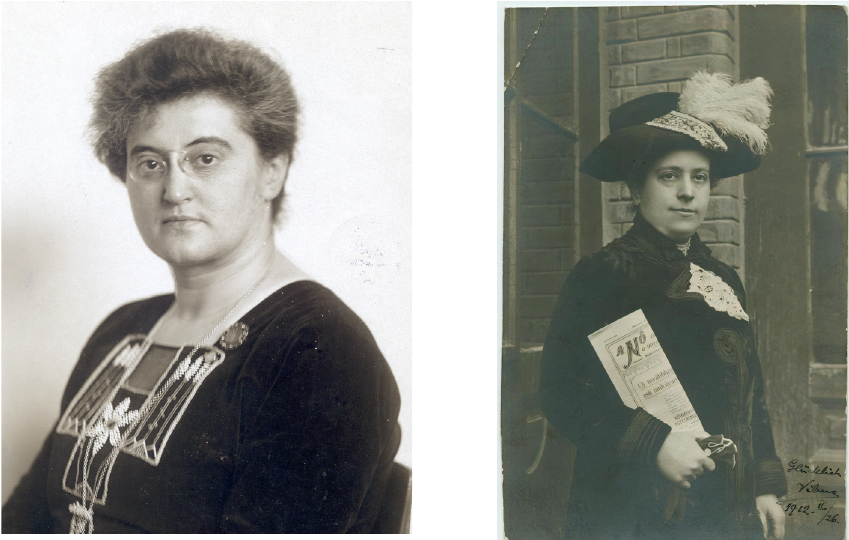
Fig. 1 The cover pages of the first issues of A Nő és a társadalom (1907) and A Nő (1914)